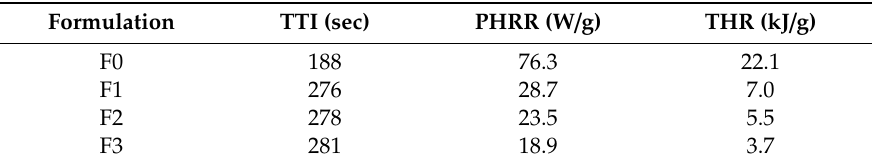
Table 3. Microcalorimeter results of the epoxy / ZrO 2